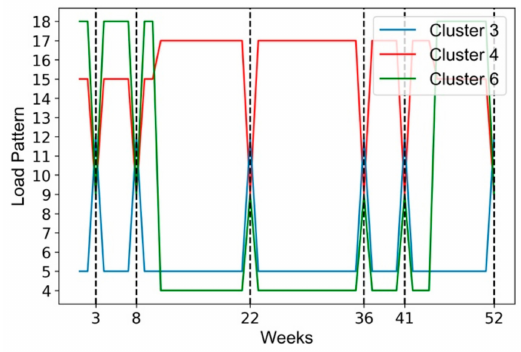
Figure 17. Special time points of abnormal user behavior changes